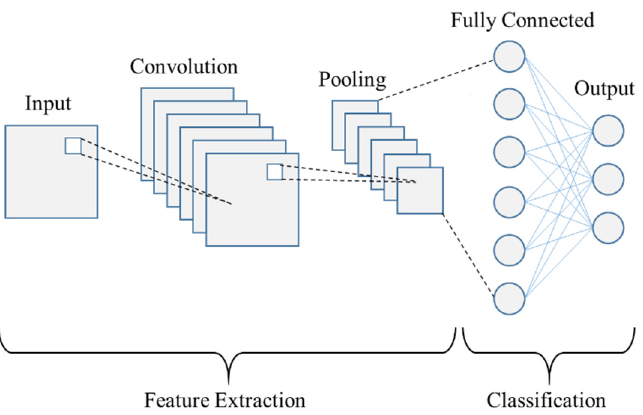
Figure 2. Common types of layers in convolutional neural networks